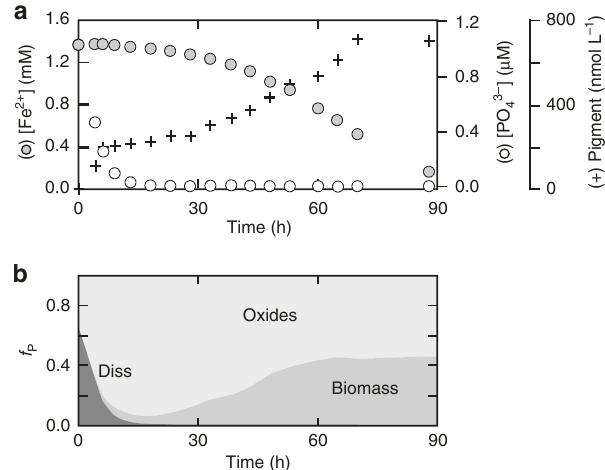
Fig. 1 Physiological data for Chlorobium phaeoferrooxidans str. KB01. a Time- series data for dissolved phosphate ( ○ ), dissolved ferrous iron ( ● ), and pigment concentrations ( + ) in batch culture. b Time-series data for the partitioning of phosphorus between dissolved PO 3 (cid:1) (diss), Fe-oxide-bound 4 phosphorus (oxides), and phosphorus in photosynthetic biomass